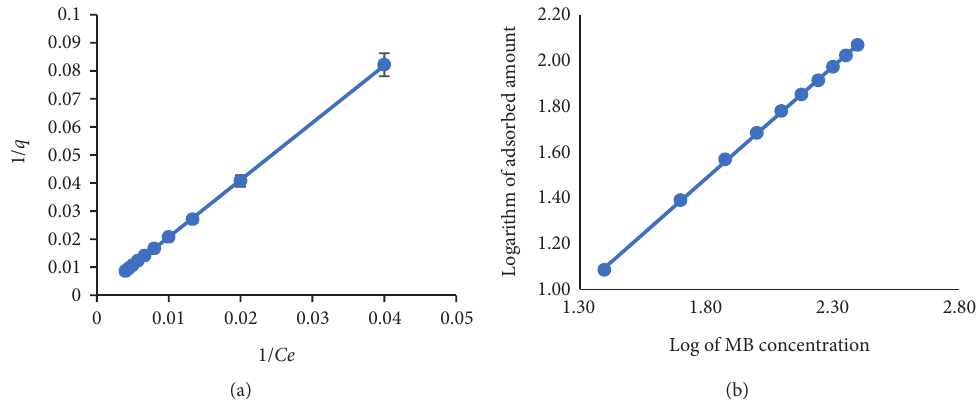
Figure 2: Sorption isotherms: Langmuir (a) and Freundlich (b) for nance peels at pH 7.